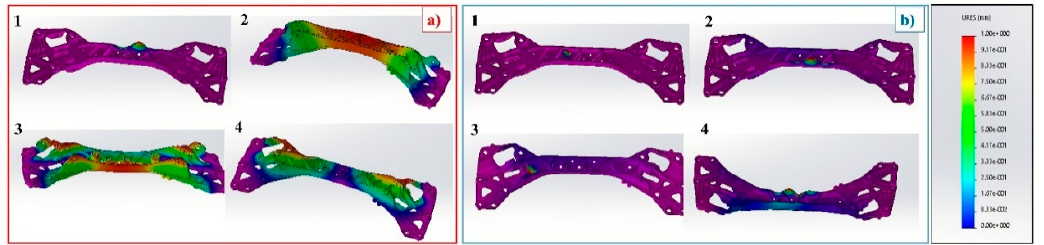
Figure 7. Displacement trend for the first four deformations for original geometry: ( a ) load case 1 (F); ( b ) load case 2